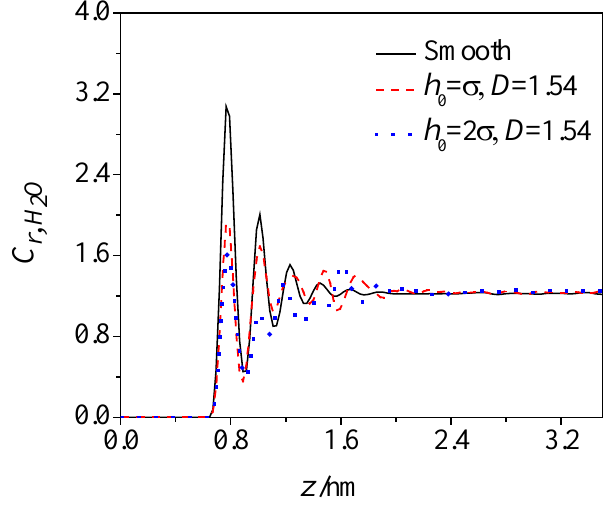
Figure 3. Effect of roughness height on concentration distribution of water molecules.